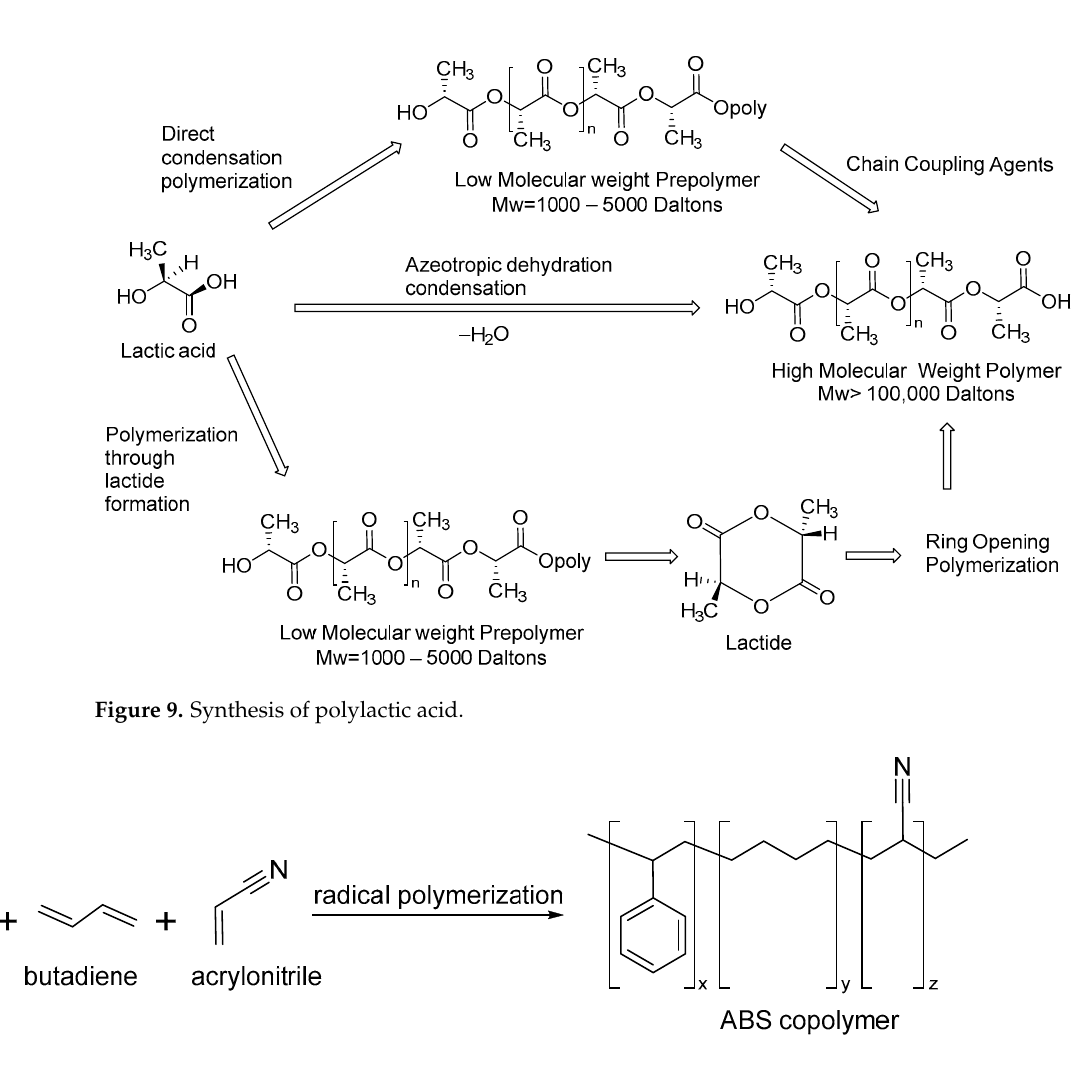
Figure 10. Synthesis of the ABS copolymer.